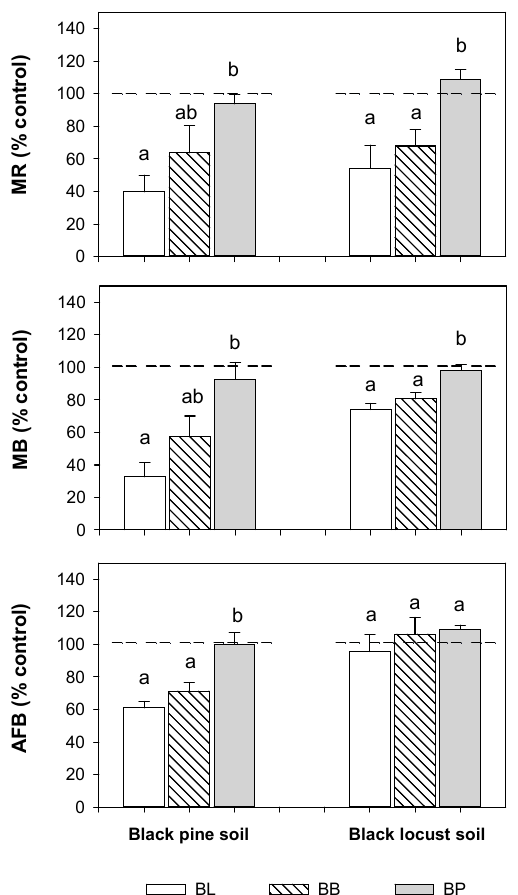
Figure 3. Changes in mineralization rate (MR), microbial biomass (MB), and active fungal mycelium (AFB) after amendment of black pine and black locust mineral soil with water extracts of newly-shed black locust, black pine and blackberry leaf litter. Changes are presented as percent of MR, MB, and AFB in non-amended (control: dashed line) soil (0–5 cm depth) and reported as the mean (±SE) from 20 samples. Different lowercase letters indicate statistically significant differences between soil samples amended with water extracts from different litters. In the boxes within panels statistically significant differences between black pine and black locust soils (two-way ANOVA, p < 0.05) are shown.